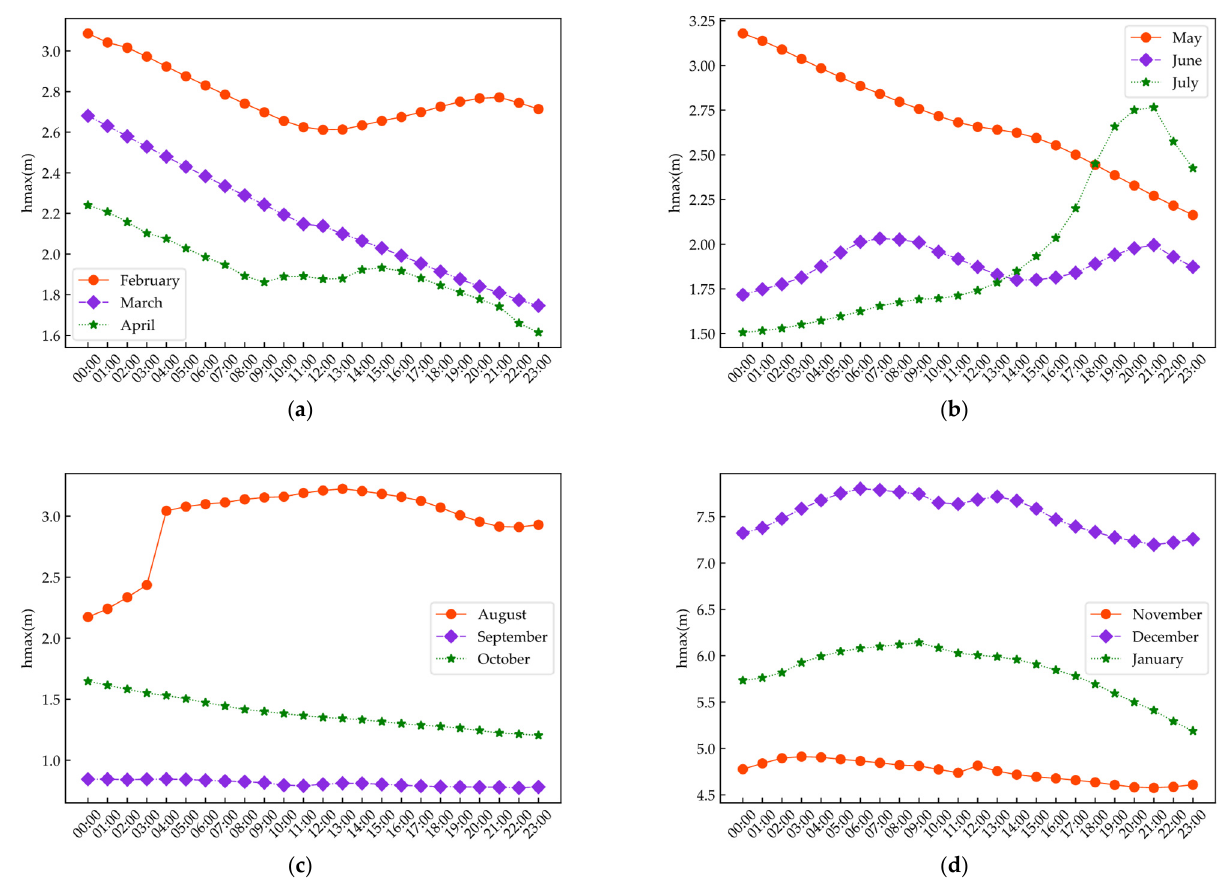
Figure 4. The diurnal variation of hmax : ( a ) The changes on 1 February, 1 March, 1 April; ( b ) The